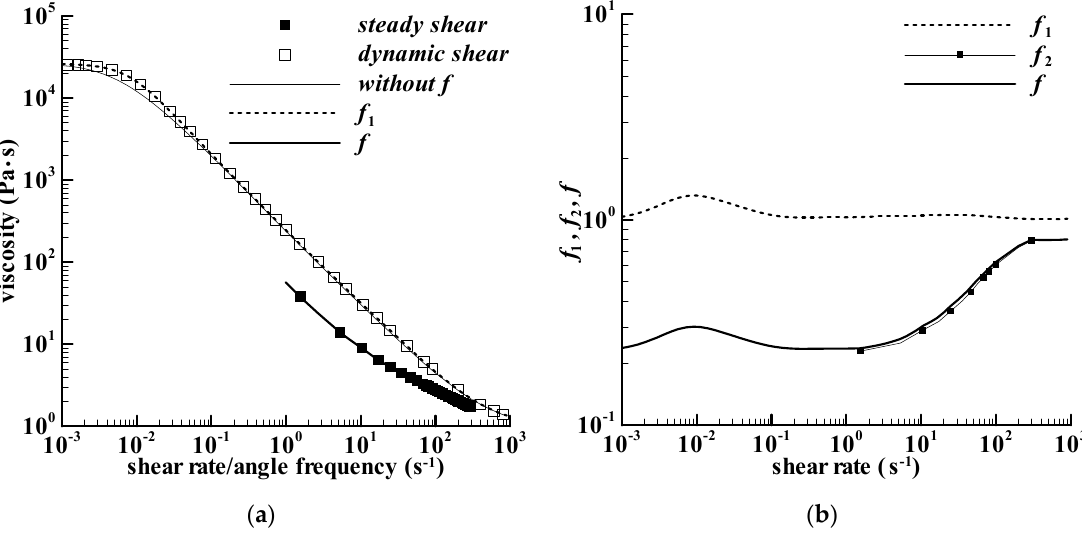
Figure 2. Viscosity of the paste and the calculation parameters used. ( a ) Viscosities of the